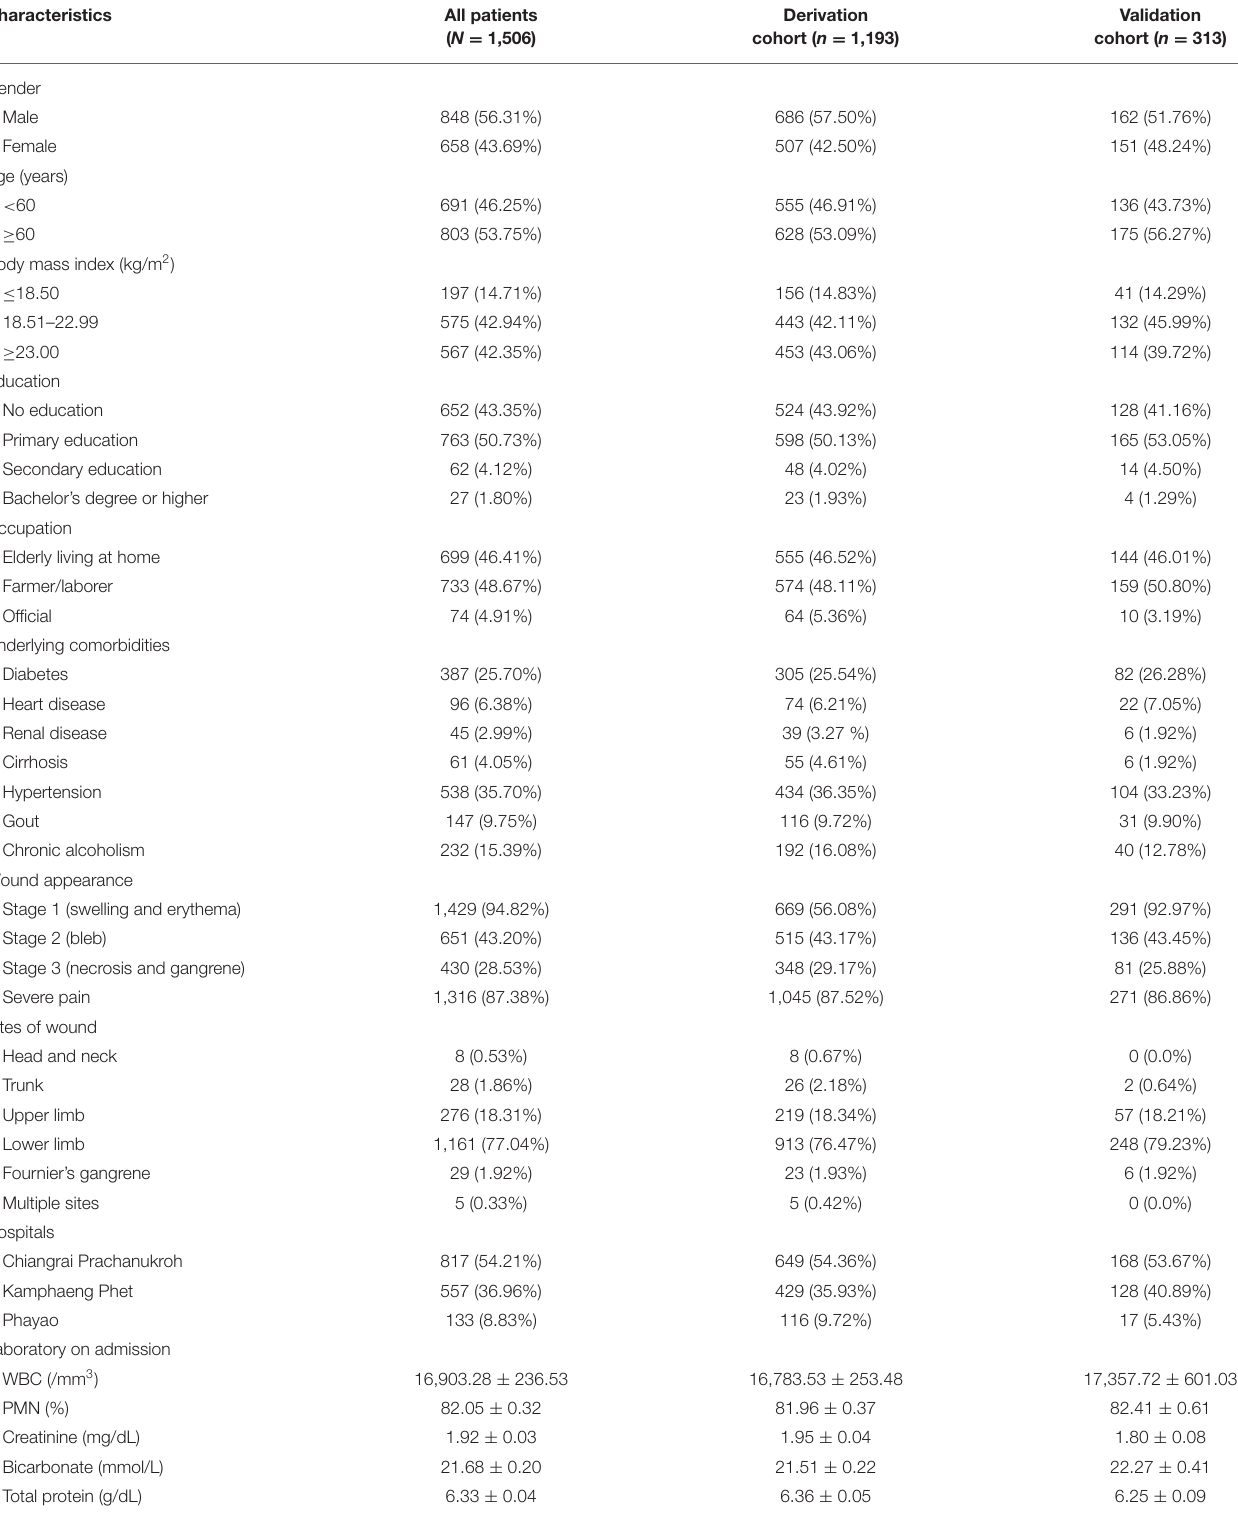
TABLE 1 | Clinical and demographic characteristics of patients with necrotizing fasciitis among all patients, and compared between the derivation cohort and the validation cohort.